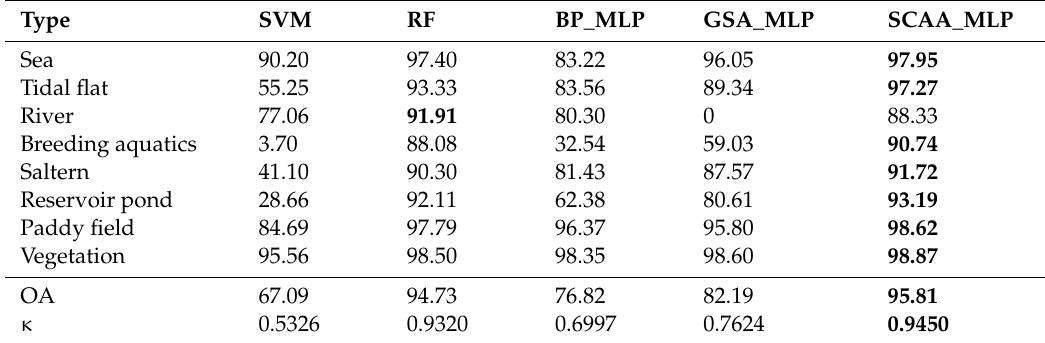
Table 4. The classification accuracy of di ff erent classifiers in Yellow River Delta wetland.